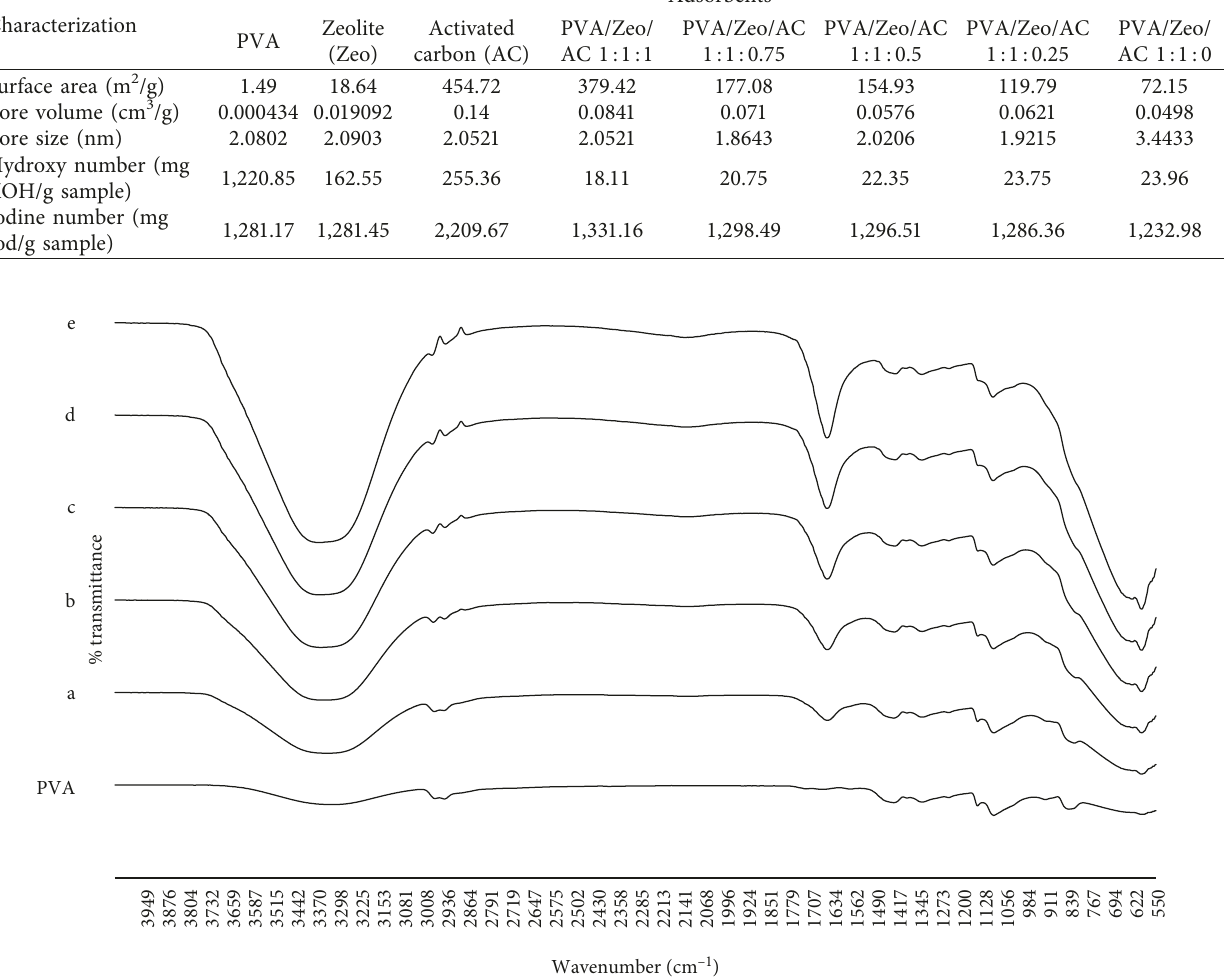
Figure 1: FTIR spectra of PVA and composite: a (PVA/Zeo/AC 1 :1:1); b (PVA/Zeo/AC 1 :1: 0.75); c (PVA/Zeo/AC 1 :1: 0.5); d (PVA/